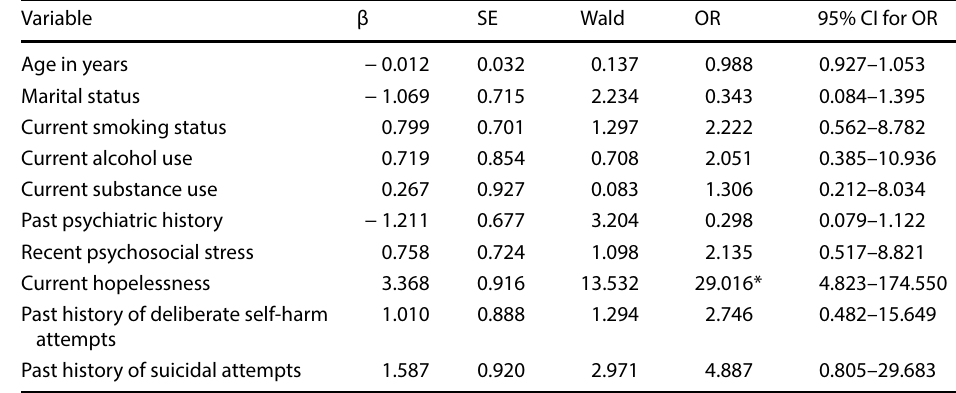
Table 5 Logistic regression analysis for predictors of those who had suicidal behavior compared those without (N = 799)